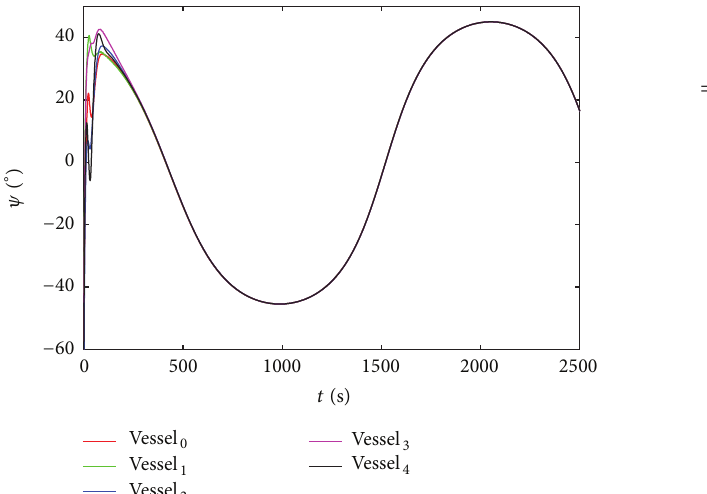
Figure 3: The heading consensus for these vessels.